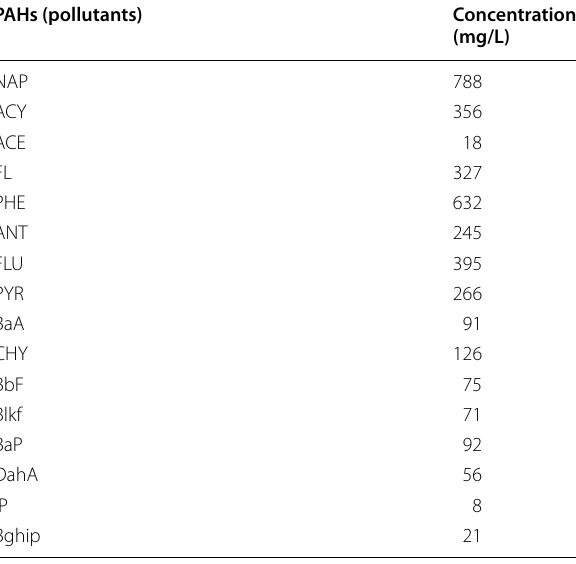
Table 2 Raw material elementary analysis using ICP‑MS Elements Apatite Groundnut shells